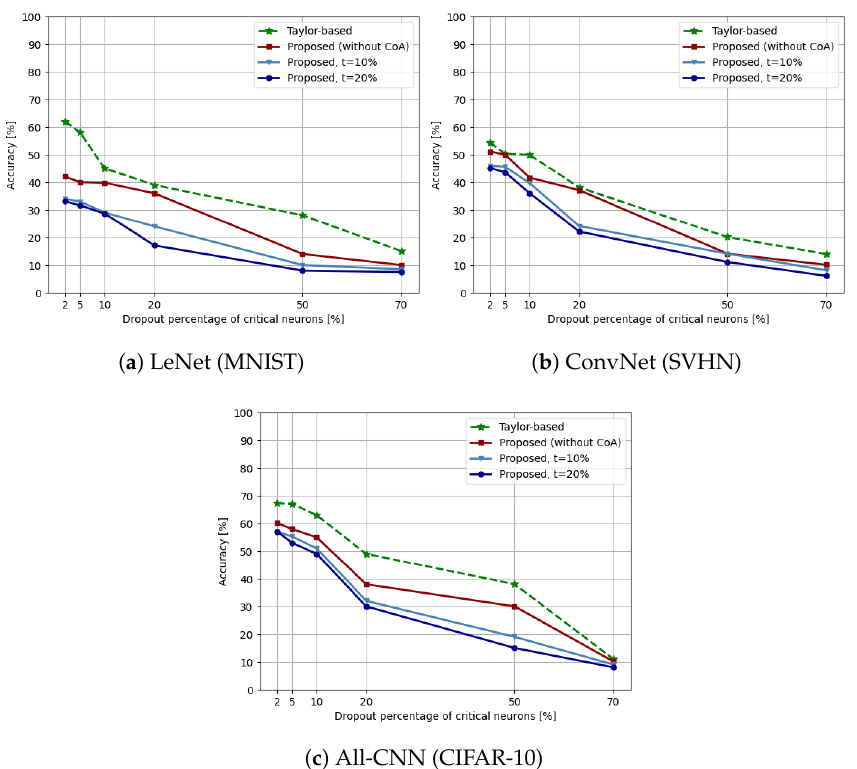
Figure 8. Showing the robustness of the proposed approach based on the contribution of the CoA and the NoA (blue